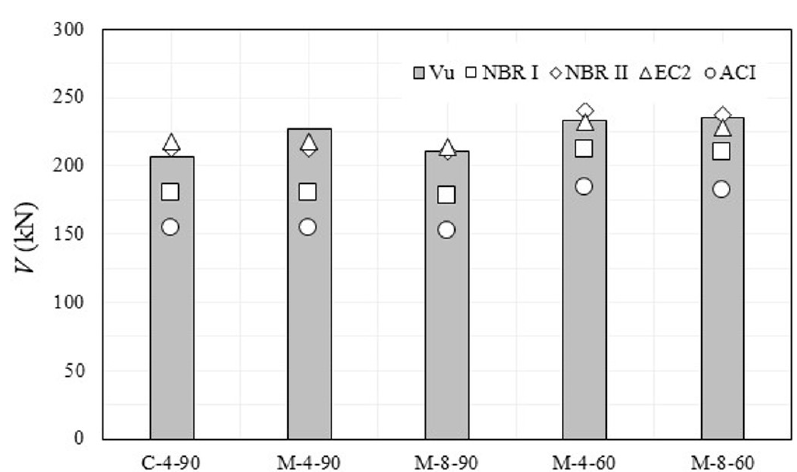
Figure 13 - Comparative graph of failure load by theoretical